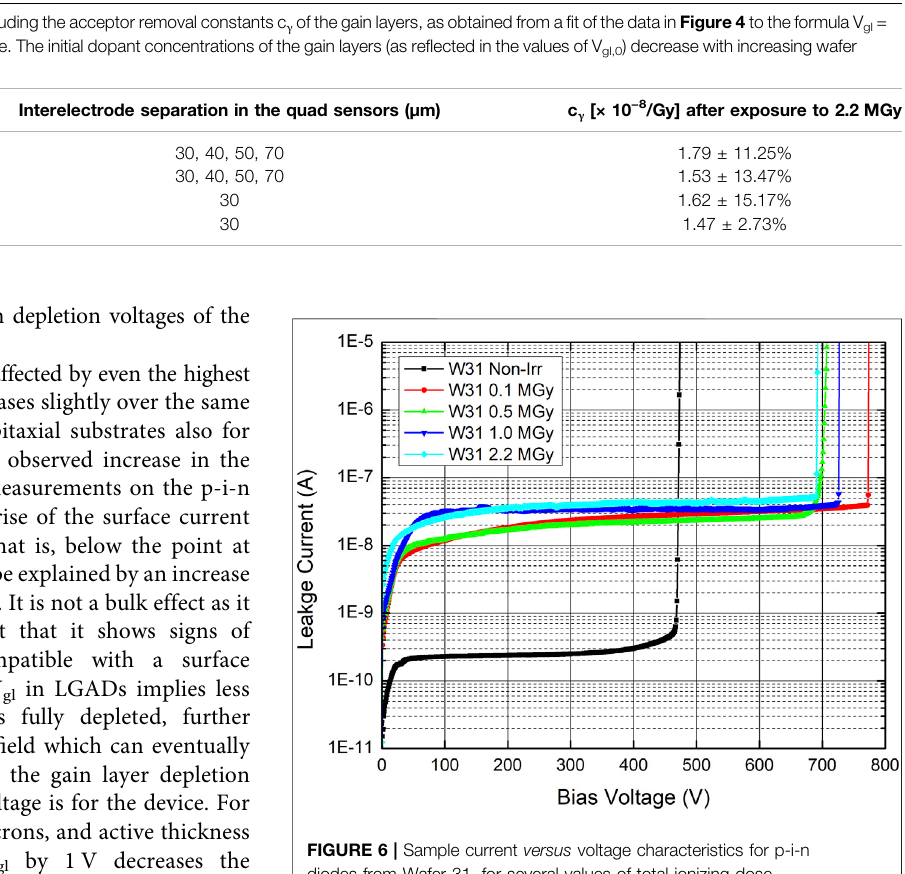
Frontiers in Physics |